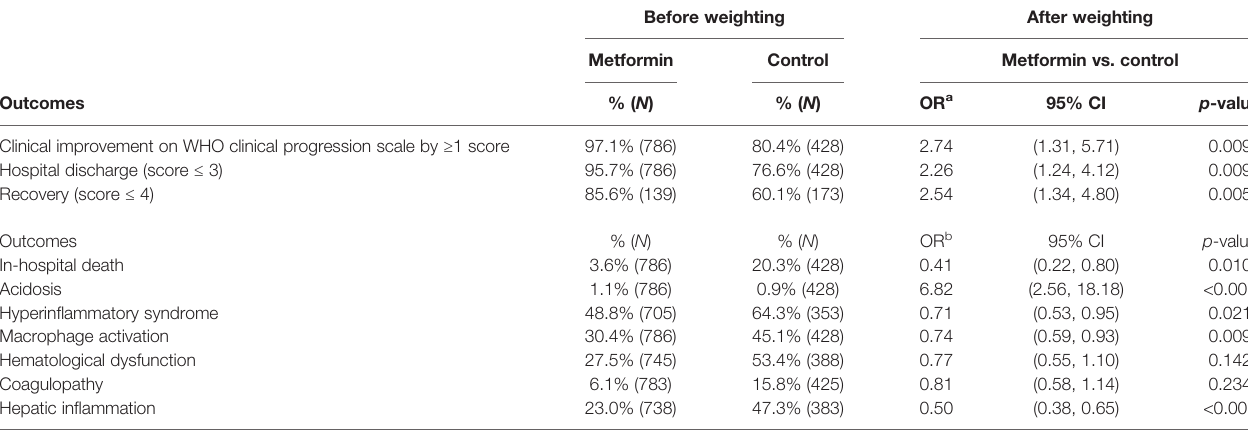
TABLE 2 | Comparison of the odds of clinical improvement, in-hospital death, acidosis, and hyperin fl ammatory syndrome between metformin and control groups. Before weighting